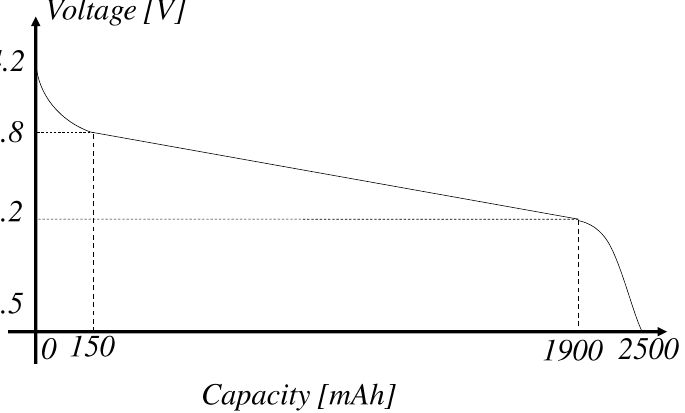
Figure 9. Characteristic curve of the 18650